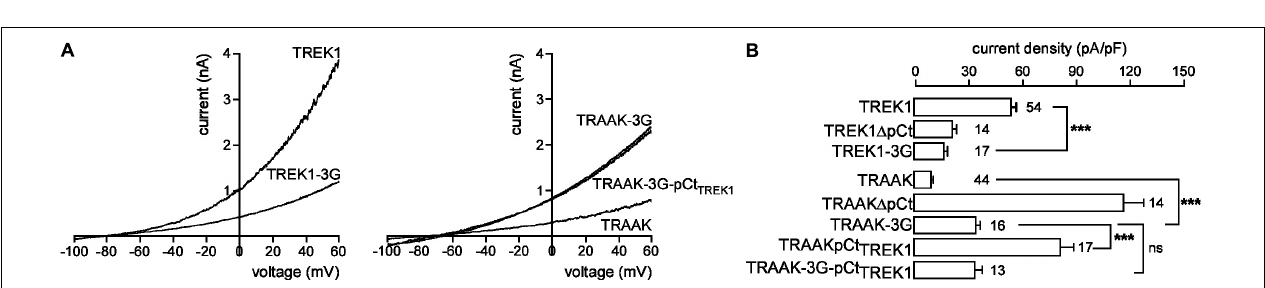
FIGURE 3 | pCt modulates TREK1 and TRAAK single-channel properties. (A,E) Single-channel recordings at +80 and –80 mV, from HEK cells expressing wild-type and mutated channels. Pipette and bath solutions contained 150 mM KCl. (B,F) Single channel current–voltage relationships obtained from one level opening current in symmetrical 150 mM KCl. (C,G) Unitary conductances at +80 and –80 mV. (D,H) Mean open time obtained from channel opening recorded at +80 mV and –80 mV. (C,D,H,G) , Data are presented as mean ± SEM, the number of patches is indicated, ∗ p < 0.05, ∗∗∗ p < 0.001, (Mann–Whitney test).